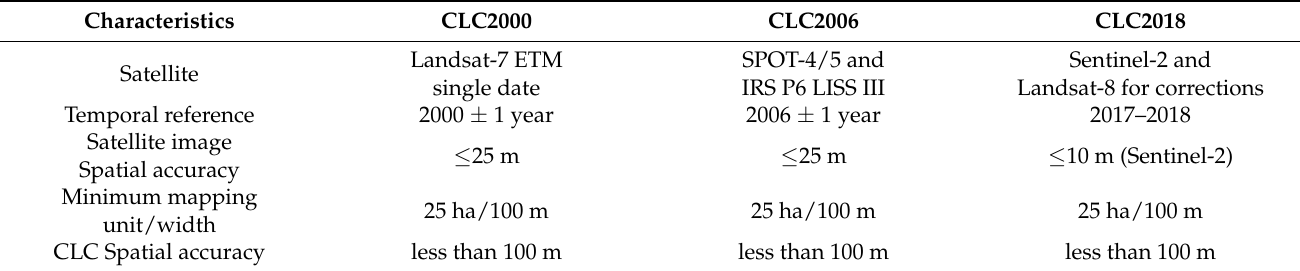
Table 2. Main features of the datasets used for the years 2000, 2006 and 2018, as reported in the metadata and technical documents